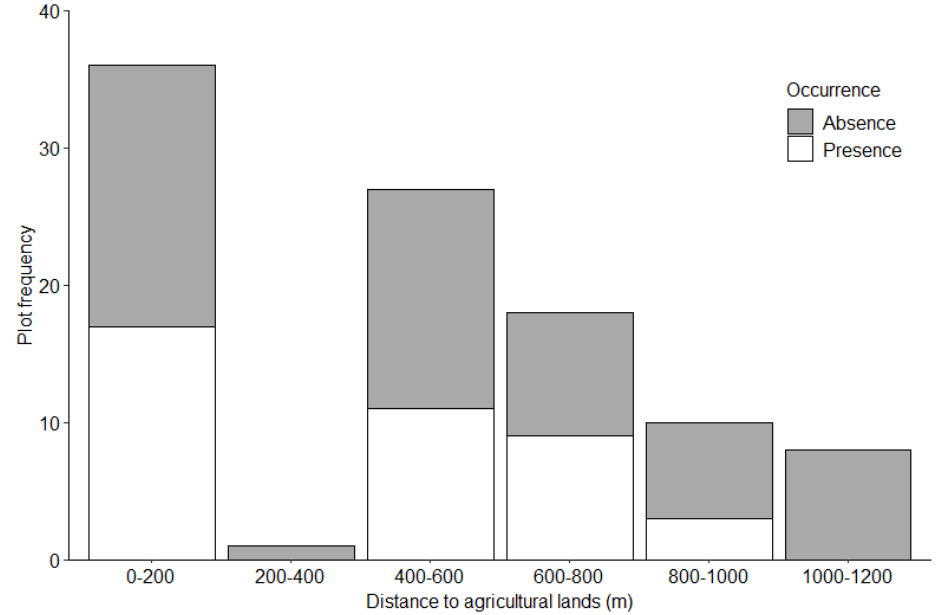
Figure 5. Chinese pangolin foraging burrow distribution by distance to agricultural lands in Chandragiri Municipality, Nepal.